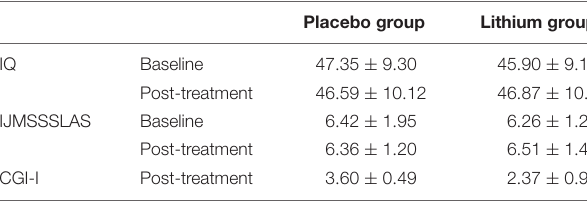
TABLE 4 | Comparisons for IQ, IJMSSSLAS and